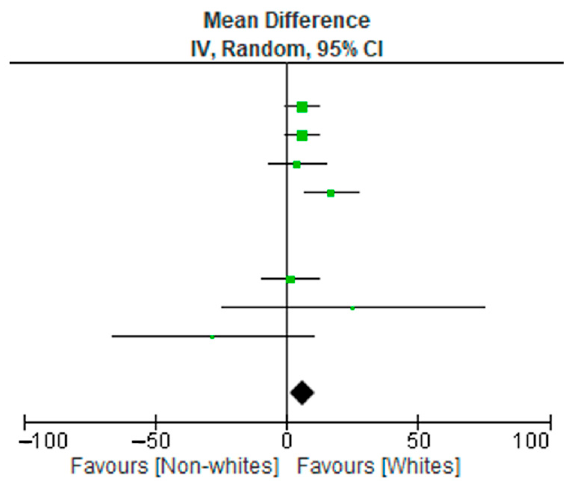
Figure 2. Forest plot data of 10 reviewed studies. The high p -value for the χ 2 test of heterogeneity ( p = 0.20) suggests that the hetero- geneity is insignificant and that a meta-analysis is appropriate for this study, shown in Figure 3. This model assumes that all included studies measure the same thing. Several studies that measured larger population sizes were excluded in order to reduce variation across